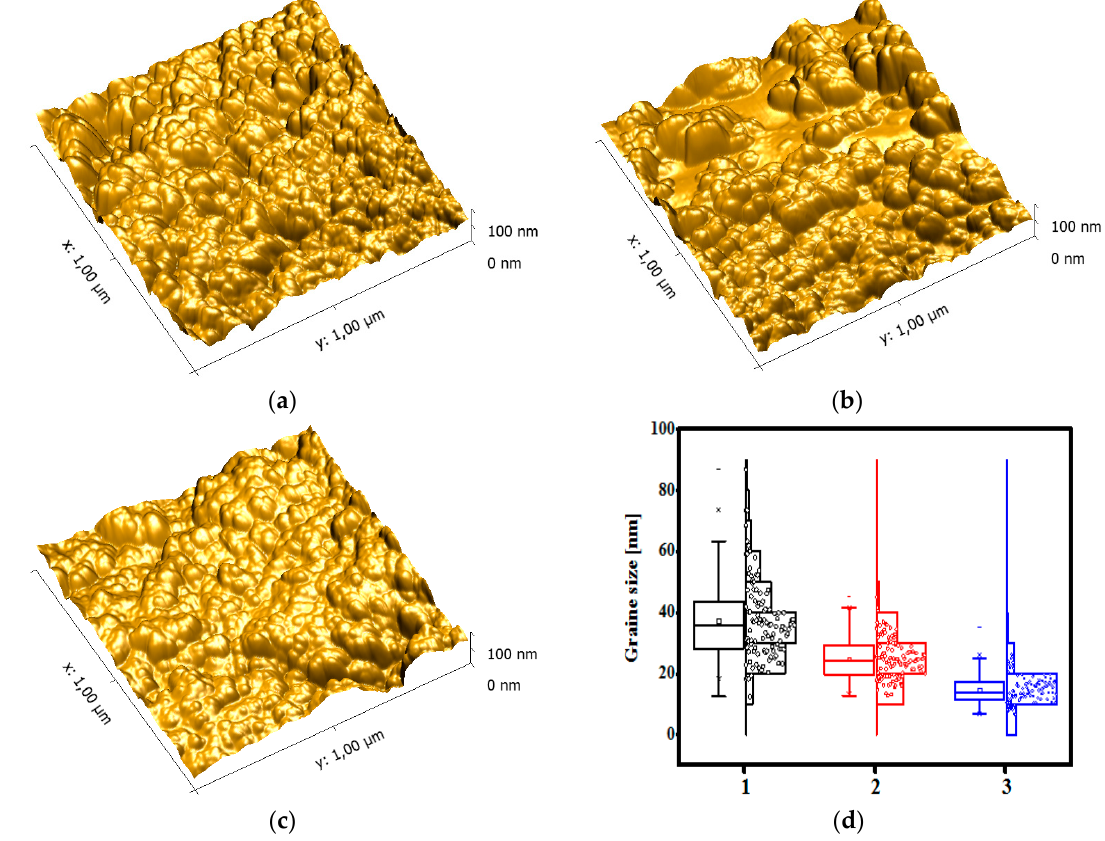
Figure 7. Atomic force microscopy (AFM) images of ( a ) initial SiO 2 nanoparticles; ( b ) SiO 2 modified with neat PDMS-20; ( c ) SiO 2 modified with mixtures of PDMS-20/DEC and ( d ) their histogram: 1—initial SiO 2 nanoparticles, 2—SiO 2 modified with neat PDMS-20, 3—SiO 2 modified with mixtures of PDMS-20/DEC.